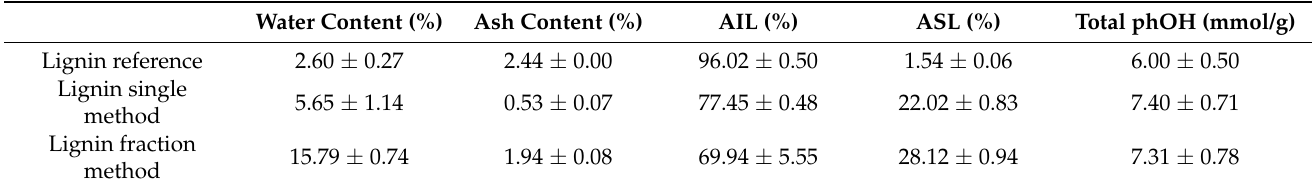
Table 1. Chemical composition of